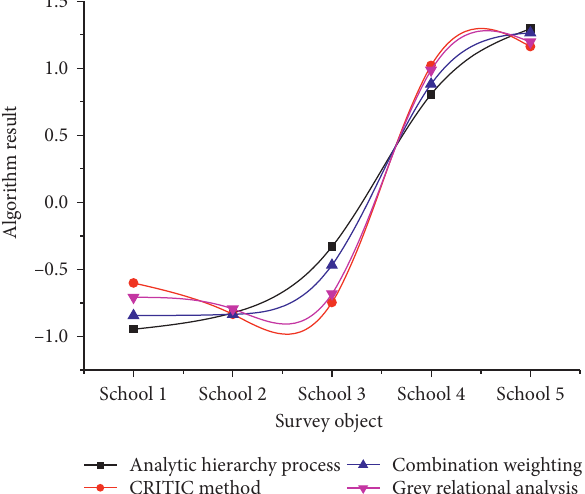
Figure 7: Evaluation values of each evaluation method in the five dimensions.